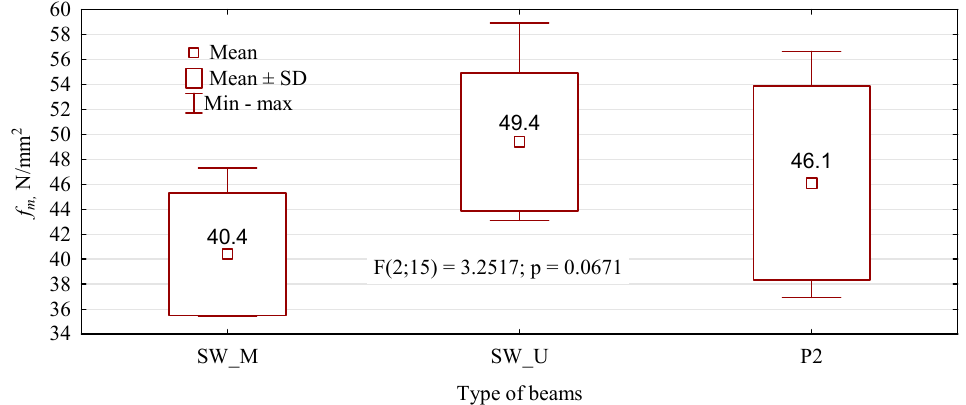
Figure 9. Static bending strength of beams with high-quality external tension lamella. All beams achieved a high average strength value, exceeding 40 N/mm 2 . Addition- ally, it is noteworthy that the minimum value is above 34 N/mm 2 . It is, therefore, in line with expectations. However, the expected effect was not achieved, as the SW_M beams had the lowest average static bending strength value, despite the best quality outer layer.